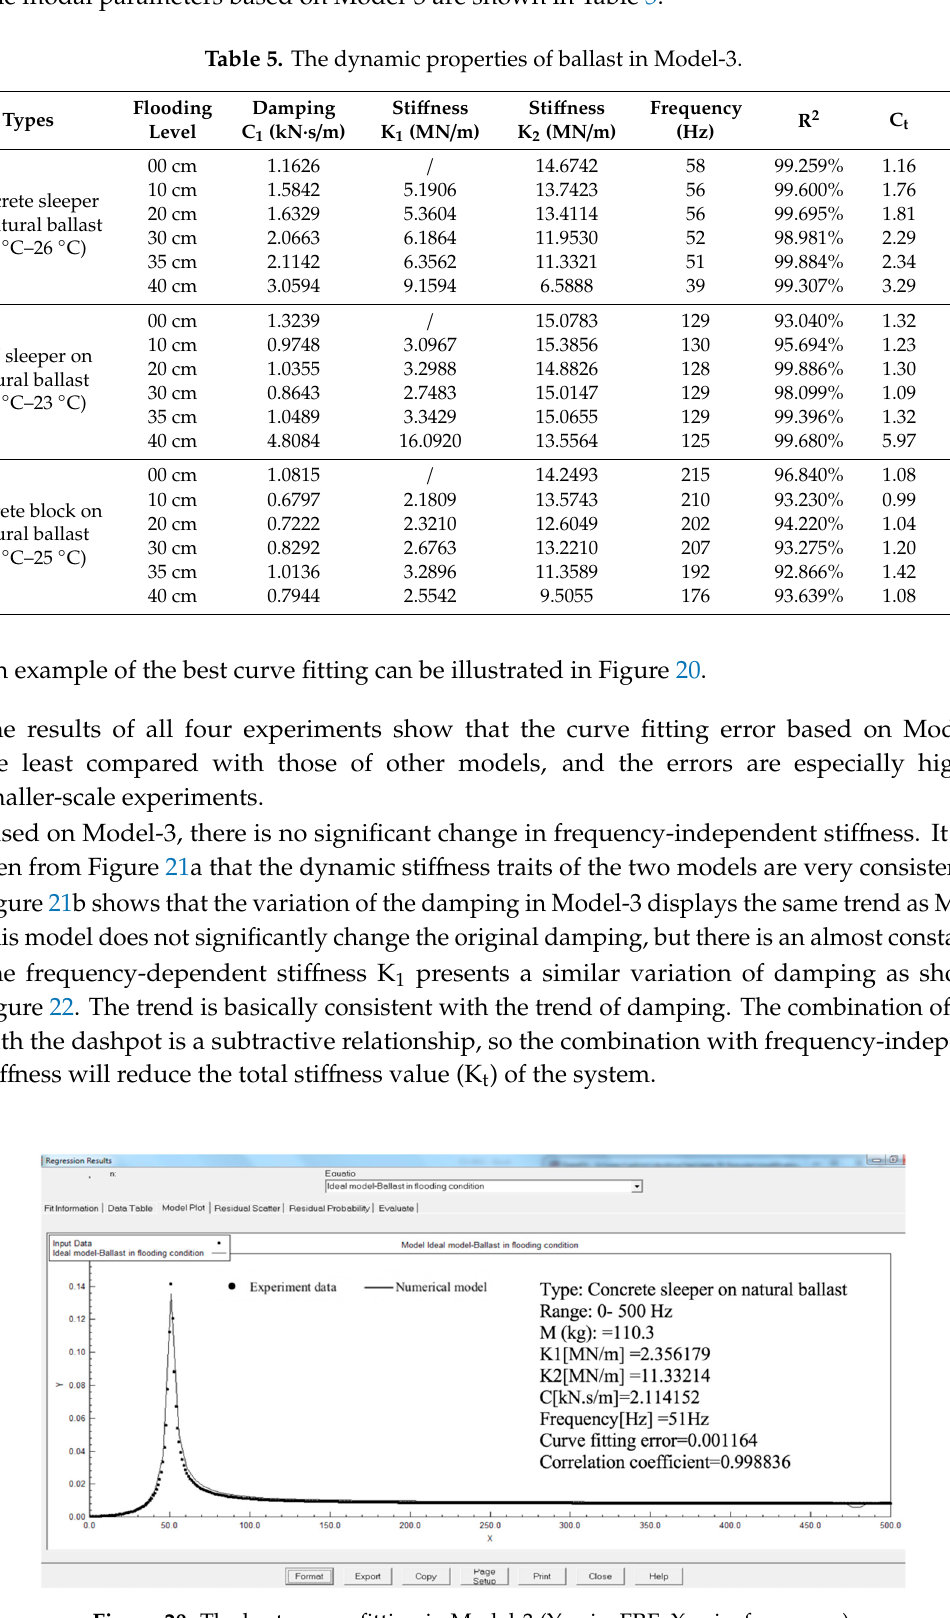
Figure 20. The best curves fitting in Model-3 (Y axis: FRF; X axis: frequency).